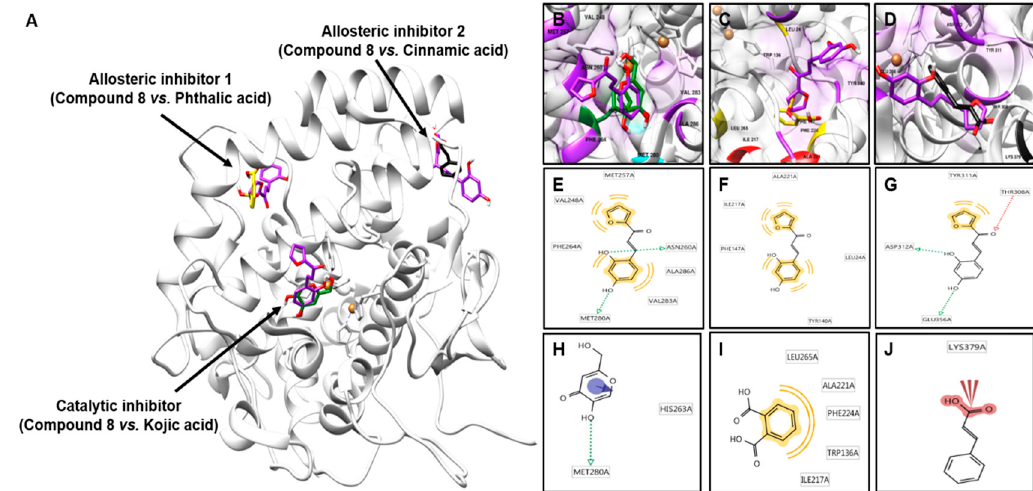
Figure 3. Molecular docking simulation models of tyrosinase inhibition by compound 8 (purple), kojic acid (green), phthalic acid (yellow) and cinnamic acid (black) ( A ). Inhibition mode of 8 at the tyrosinase catalytic site with the catalytic inhibitor, kojic acid, ( B ) and at allosteric sites 1 and 2 with the allosteric inhibitors, phthalic acid ( C ) and cinnamic acid ( D ), respectively. Red: oxygen and orange: copper. 2D ligand interaction diagrams of the catalytic ( E ) and allosteric ( F , G ) of tyrosinase by compound 8 , and kojic acid ( H ), phthalic acid ( I ) and cinnamic acid ( J ) as catalytic and allosteric inhibitors, respectively. Green and red arrows: hydrogen-bonding, yellow: hydrophobic interaction and red bold line: negative ionizable area. Table 2. Binding sites and docking scores of compound 8 in mushroom tyrosinase (Protein data Bank (PDB) ID: 2Y9X), as determined using the AutoDock 4.2 program.